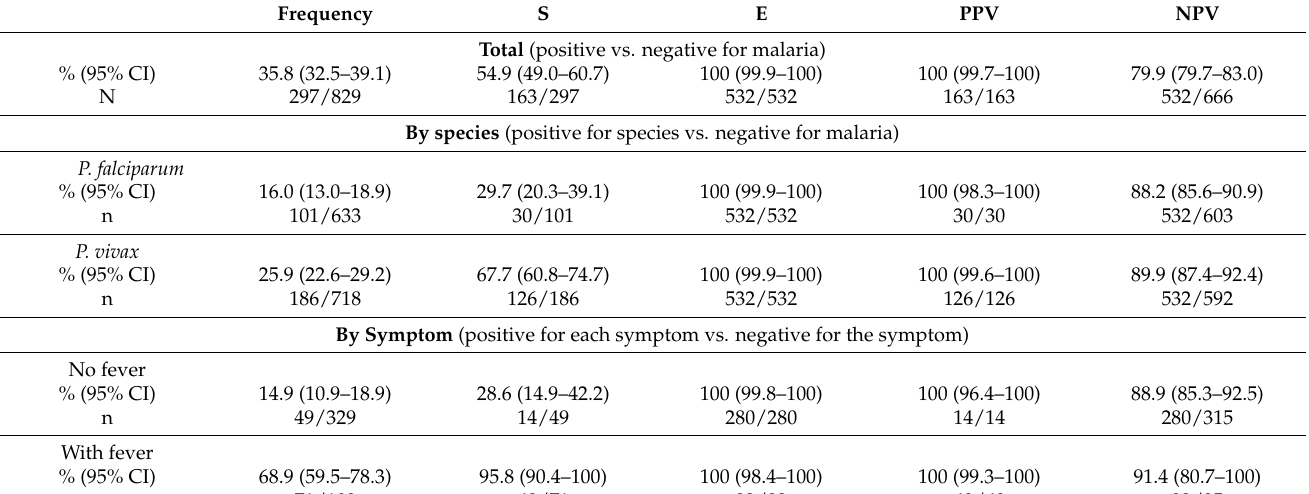
Table 2. Frequency, sensitivity, specificity, and predictive values of the TBS compared to qPCR for the diagnosis of gestational malaria in the total population and in subgroups according to species, symptomatology, and history of